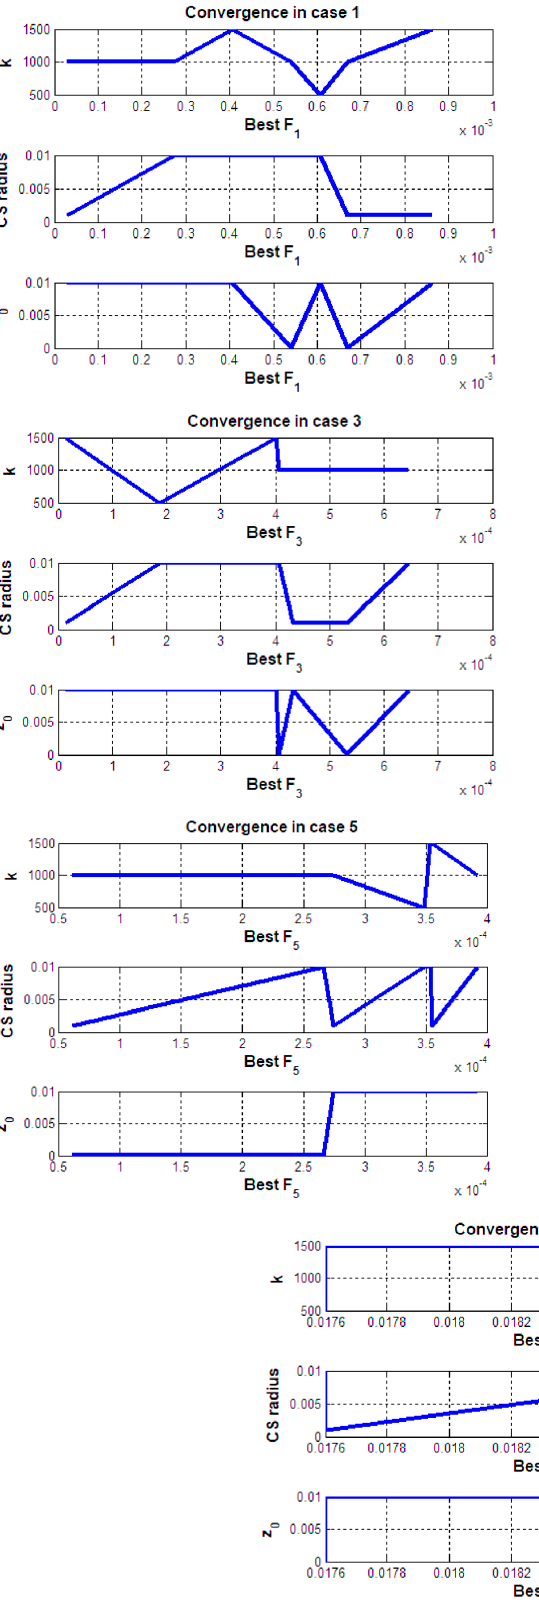
Figure 12. The convergence of F for all NSEs cases with the chaotic search